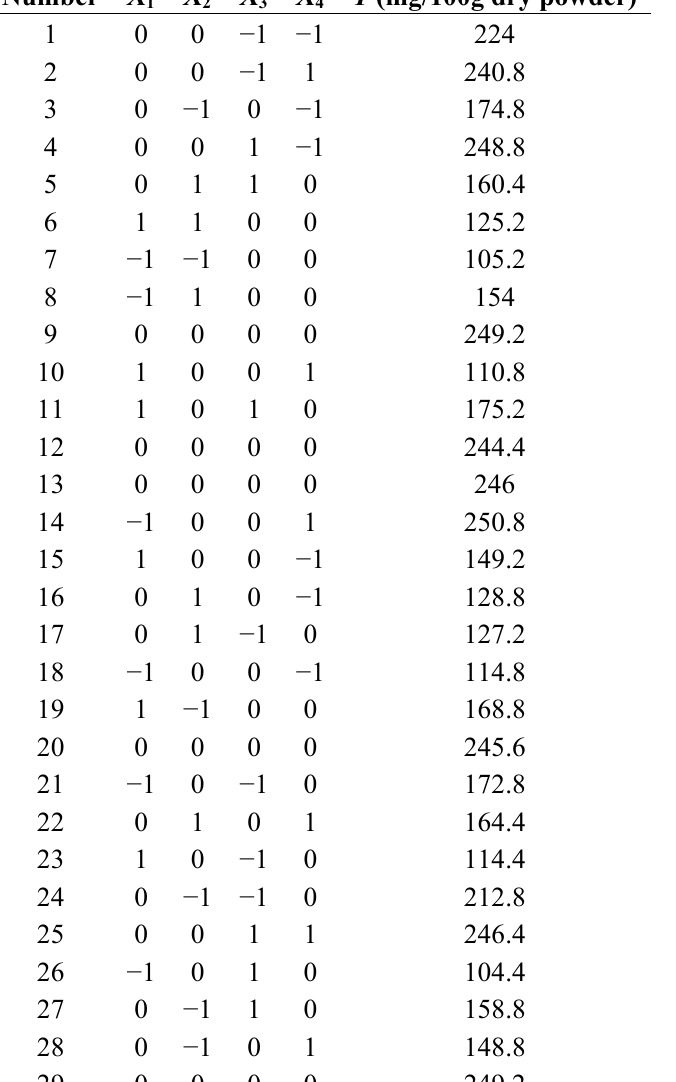
Table 1. Experimental design using Box-Behnken and the extraction yields of